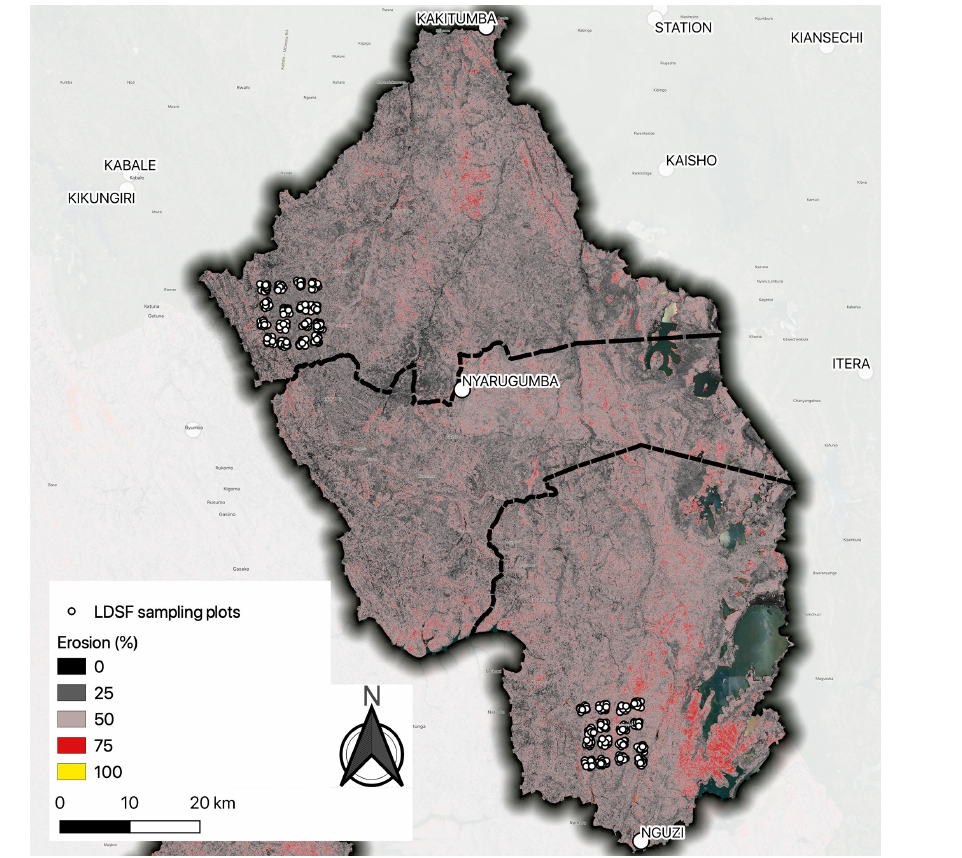
Figure 8. Map of soil erosion prevalence (%) across Nyagatare, Gatsibo, and Kayonza districts (Eastern Province, Rwanda) predicted based on Landsat 8 satellite imagery and field data from the LDSF plots. The two LDSF sites are also shown on the map (Nyagatare in the north and Kayonza in the south), with the sampling plots shown as white